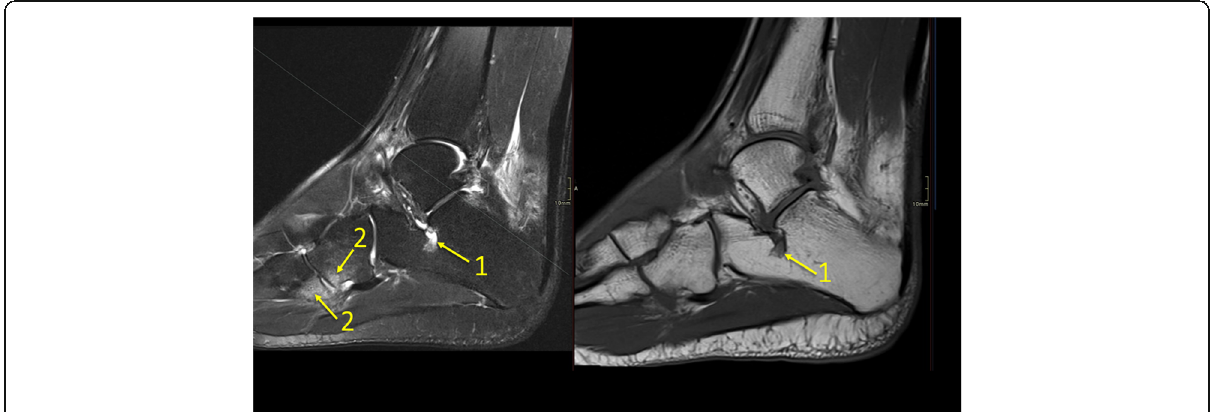
Fig. 34 A 30-year old patient after ankle joint sprain. Radiographs revealed a Lisfranc fracture-dislocation. (1) MRI showed a vascular remnant, a pitfall, in the calcaneus. (2) BME was seen at the level of the Lisfranc